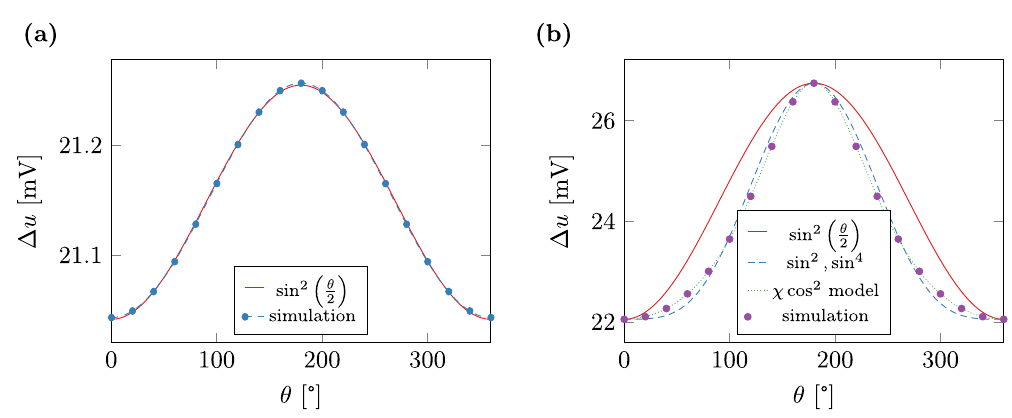
Figure 4. Potential difference Δ u between top and bottom contact required to generate an average current density of j e = 10 12 A/m 2 depending on the tilting angle of the magnetization in the free and fixed layer of a magnetic multilayer structure along with fits to different models for ( a ) J = 0.013 eV and β ′ = 0.1 ( b ) J = 0.082 eV and β ′ =